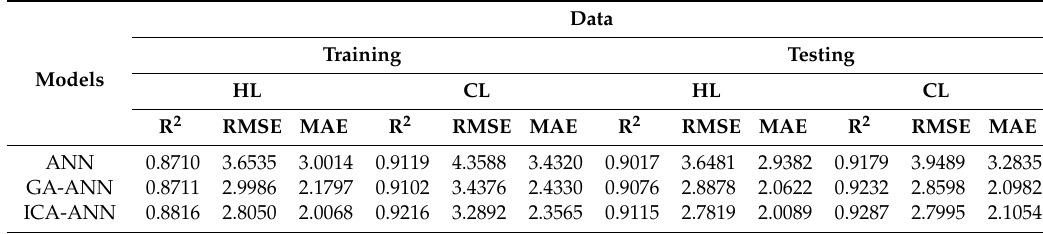
Table 3. Obtained MAE, RMSE, and R 2 for ANN, GA-ANN, and ICA-ANN results.